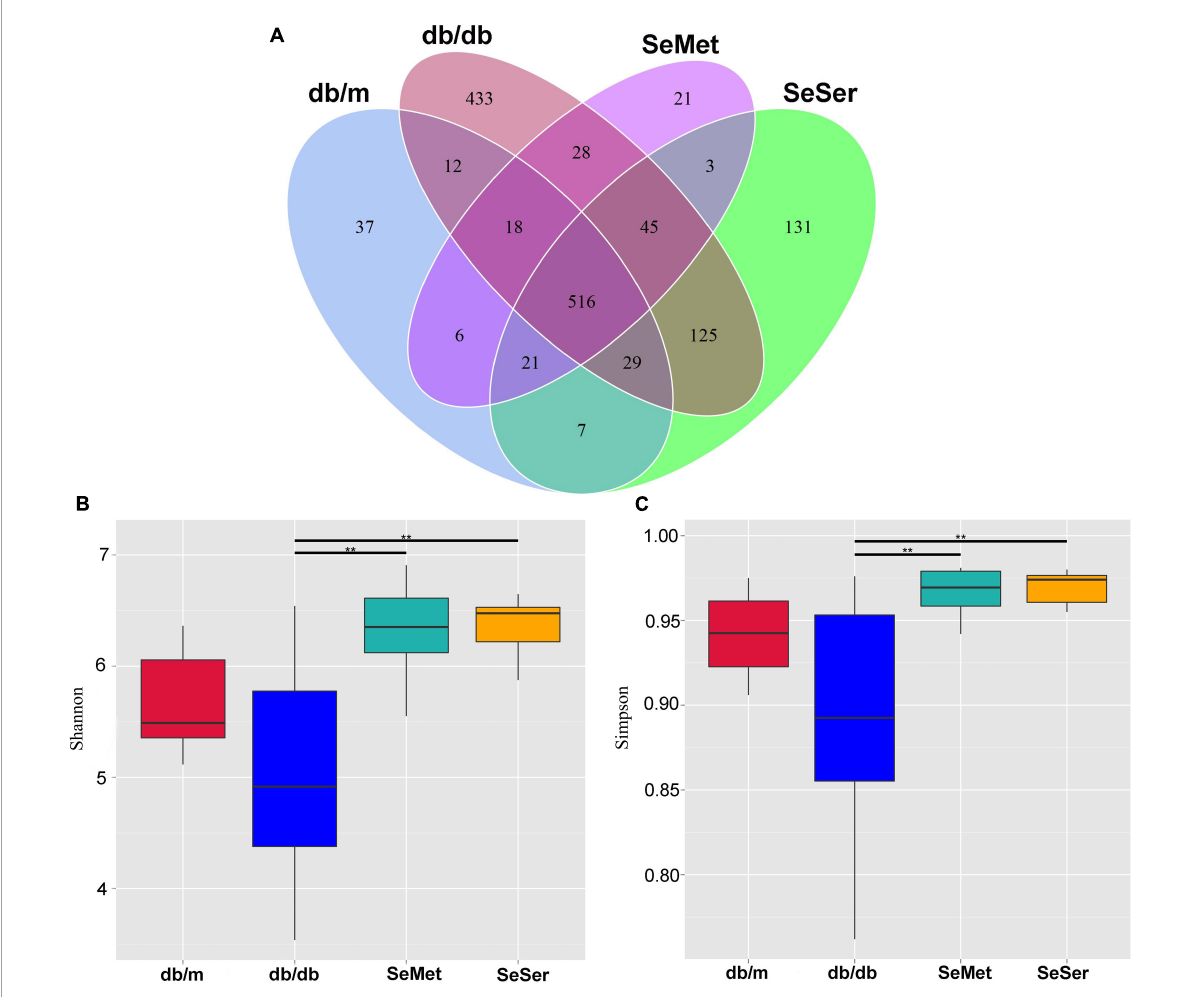
FIGURE3 Administration of selenomethionine and serine increased alpha-diversity of gut microbiota in db/db diabetic mice. (A) Venn diagram of OTUs; (B) Shannon index; (C) Simpson index. Values are expressed as mean ± SEM, n = 8. ** P <